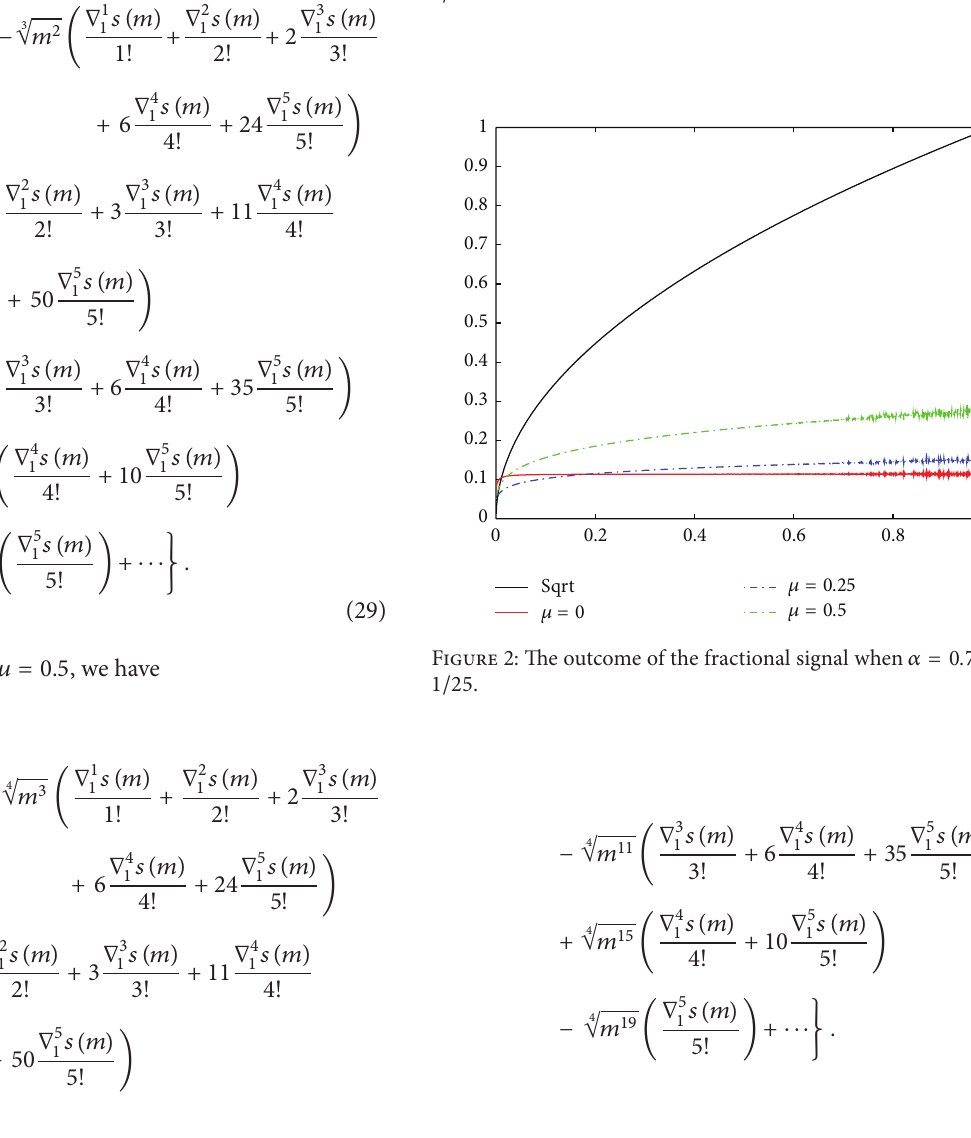
Figure 1: The outcome of the fractional signal when 𝛼 = 0.5 , 𝑇 = 1/25 .